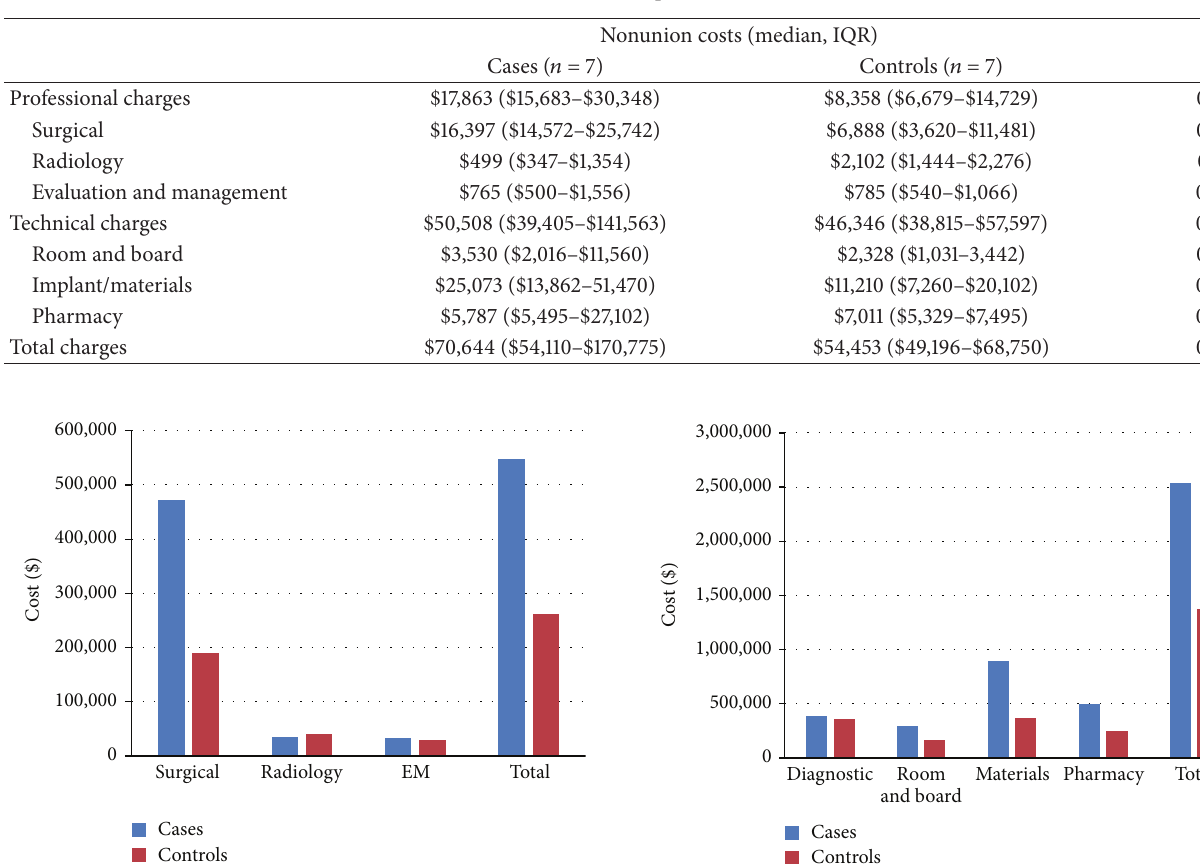
Table 3: Case versus control comparison for nonunion costs.